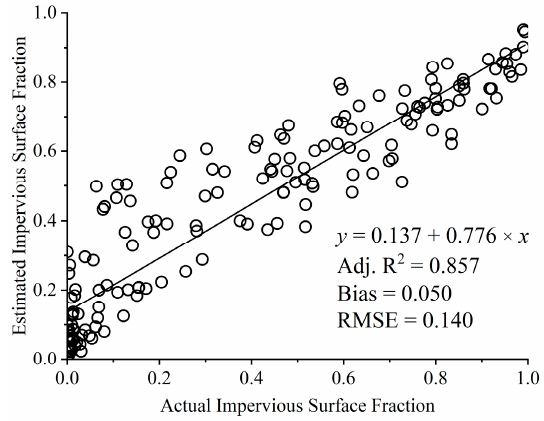
Figure 6. Scatter plot of accuracy assessment results for extracting impervious surfaces from 170 sample areas.